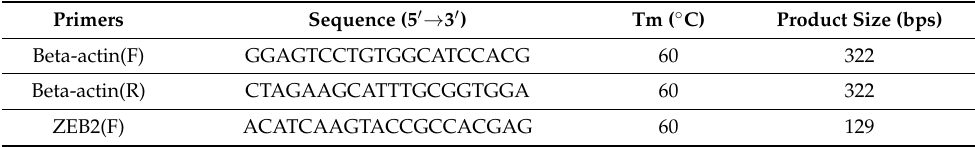
Table 2. List of primer pairs used for